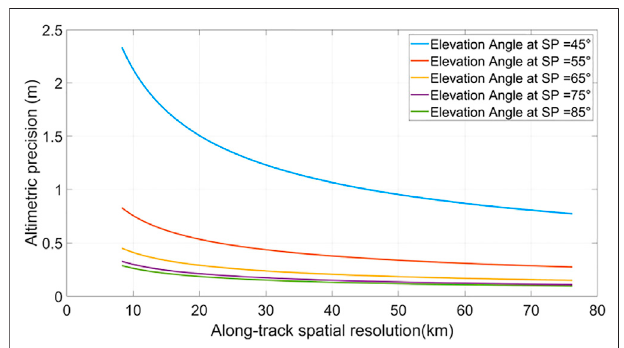
FIGURE 10 | Relationship between precision and spatial resolution under different elevation angle at antenna gains of 23 dBi the spaceborne